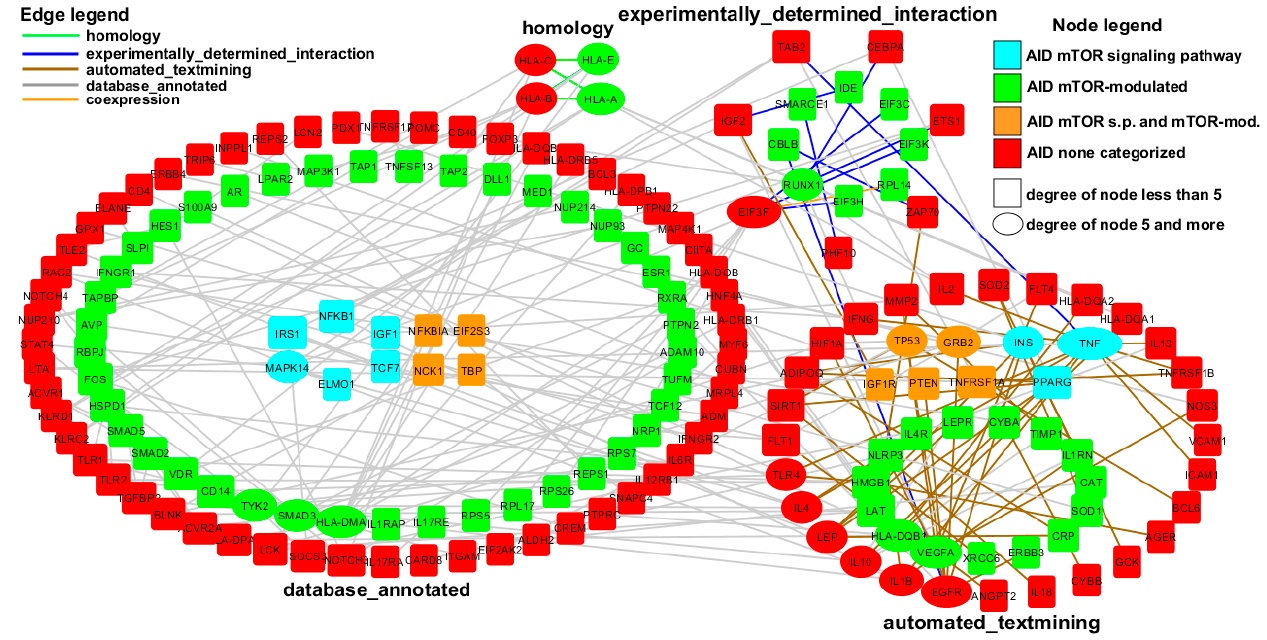
Figure 4. mTOR signaling and mTOR-modulated AID genes interacting with non-categorized AID genes. The right legend shows the color of the node description. The left legend shows the interaction type colors. The complete list of the most connected genes and their nodes degree is given in Supplementary Table S3.